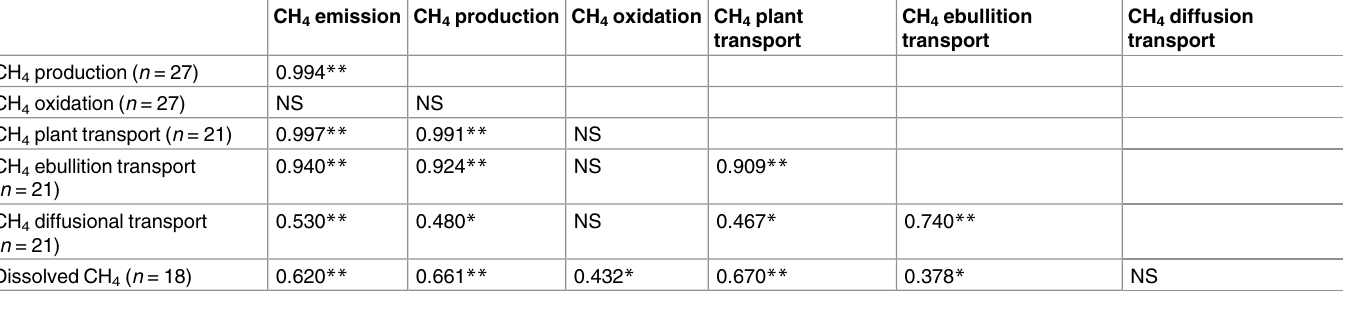
Table 1. Pearson correlation coefficients between CH 4 emission, production, oxidation, and transport and the concentration of dissolved CH 4.